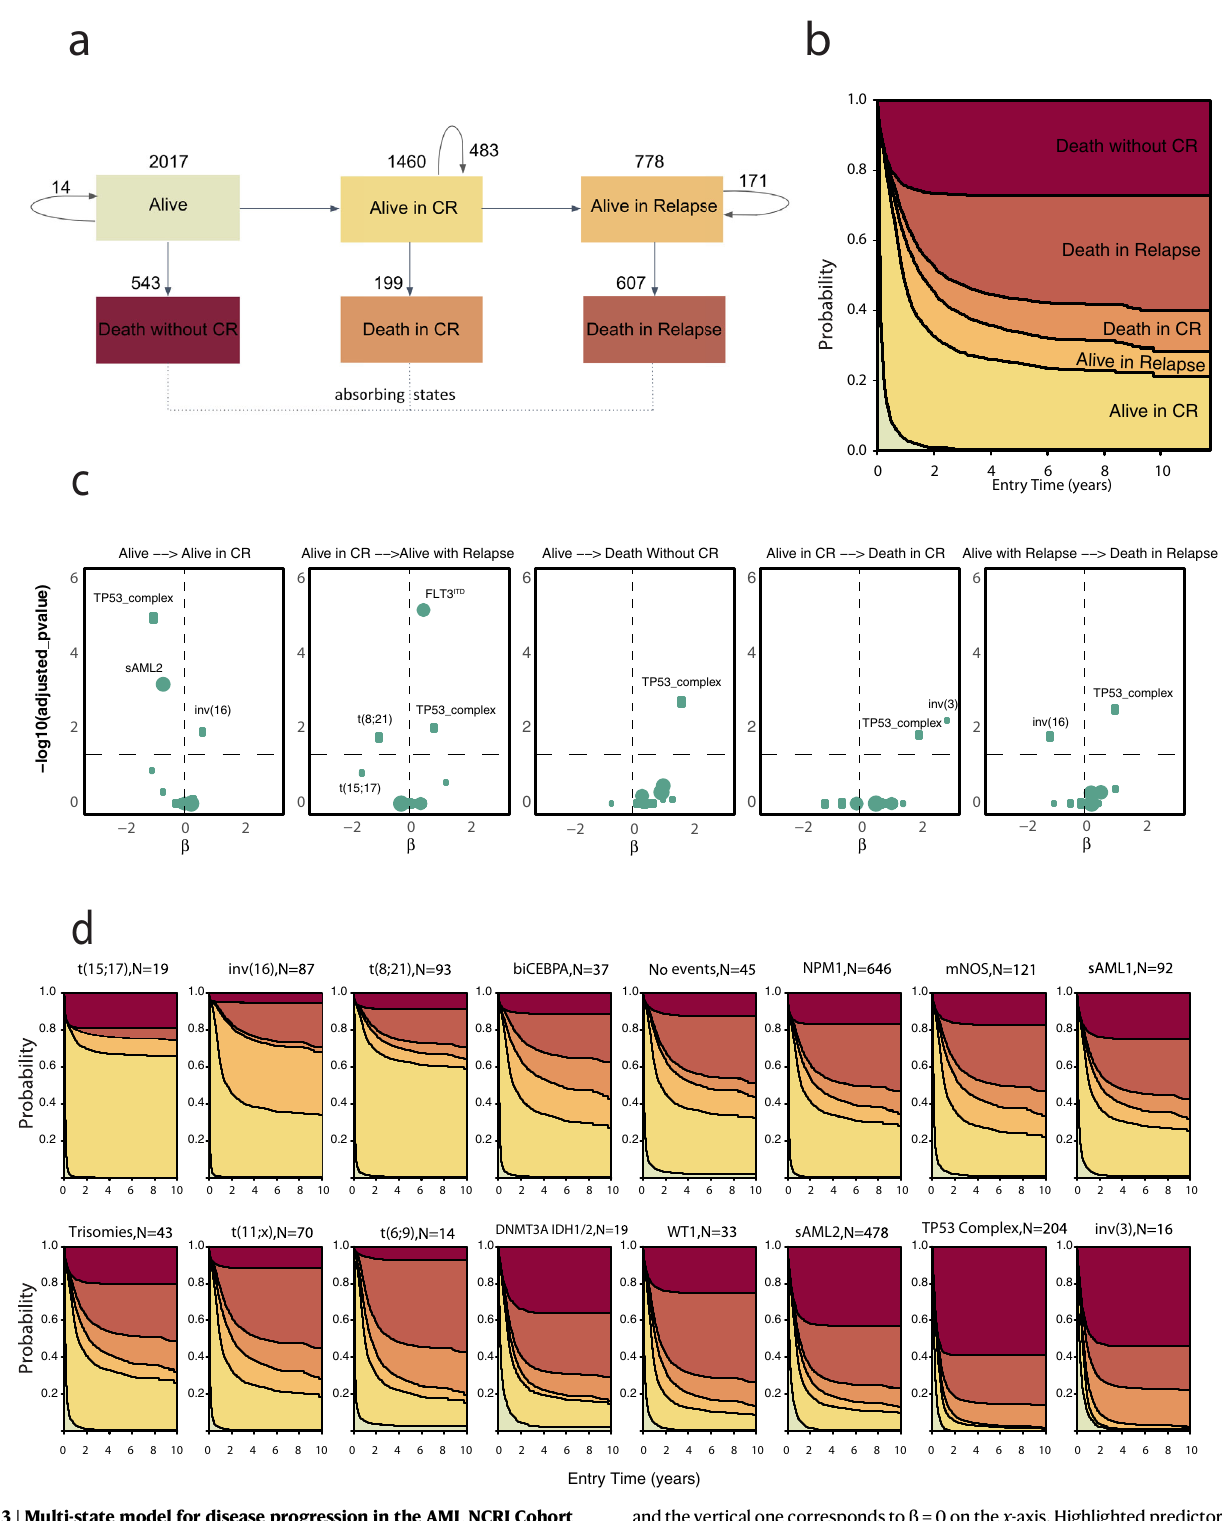
andtheverticalonecorrespondsto β =0onthe x -axis.Highlightedpredictorshave a signi fi cant effect or have large β coef fi cients ( p -value greater than the threshold: 0.05 here or p -value close to threshold and | β |>1.5). The size of each point corre- sponds to the frequency of the event. The reference class in the Cox transition models is no events. Wald test p -values are adjusted to correct for multiple com- parisons. d Stacked transition probabilities for each class ( y -axis) across time ( x - axis). The bold lines represent the transition states. We omitted n =96 patients fromthemulti-statemodelfordiseaseprogression(2113 – 96=2017)duetomissing